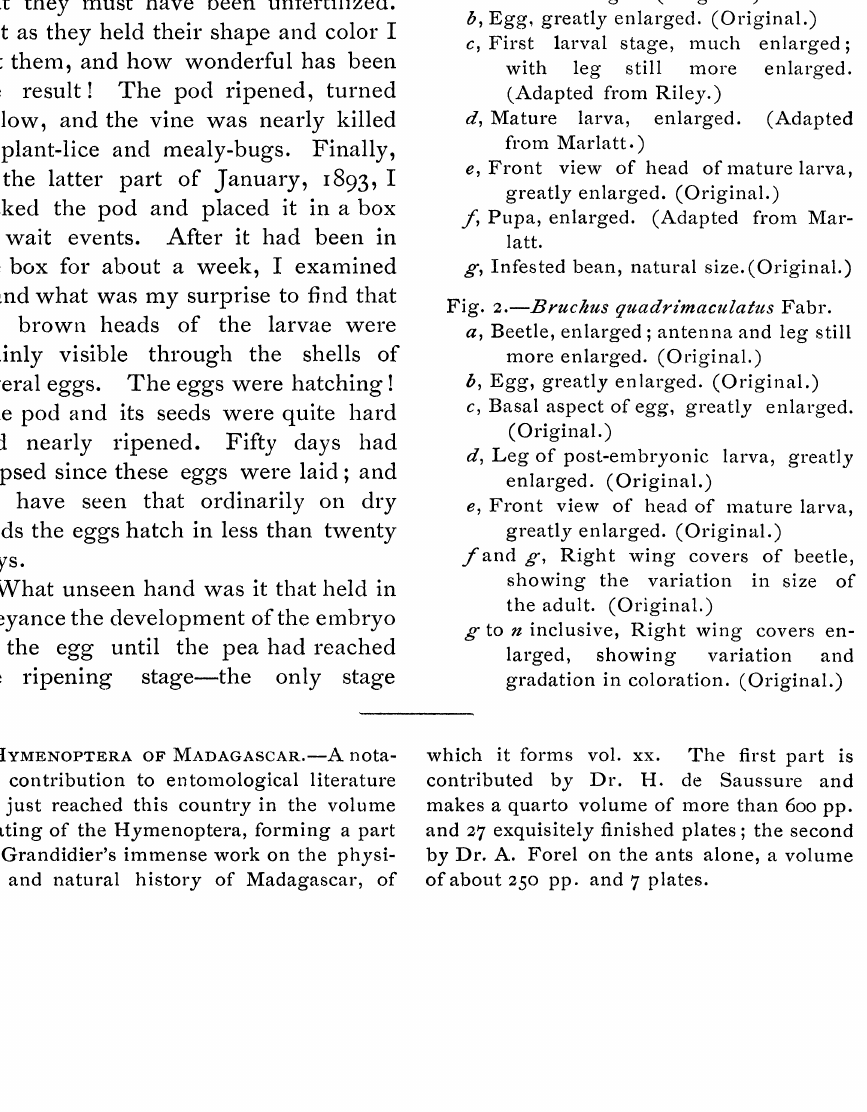
Fig. I.--Bruchus obtectus